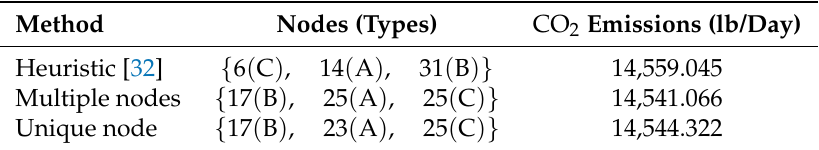
Table 4. Comparative results between literature and the proposed approach.